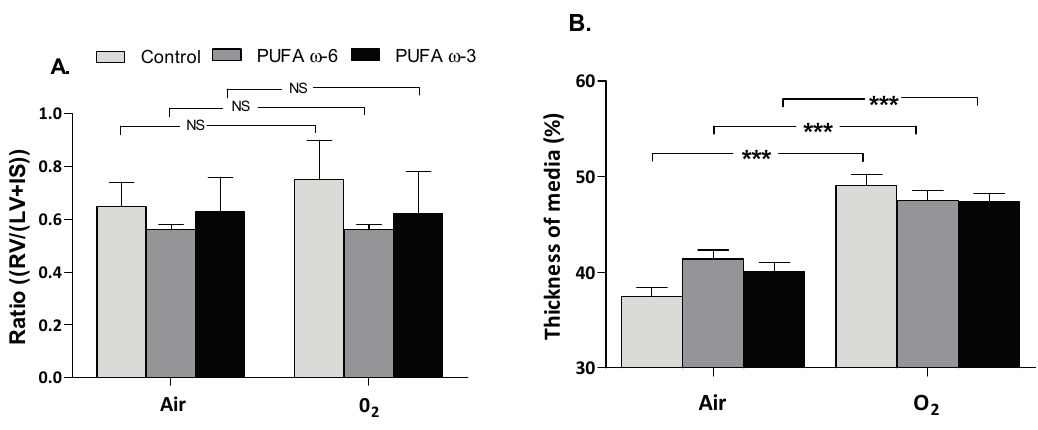
Figure 5. Heart and distal pulmonary arteries morphometry, comparing ratio (RV/(LV + IS)) in newborn rats exposed to hyperoxia or not ( A ) and the thickness of the media of distal pulmonary arteries ( B ) according to exposure and type of supplementation. Values are expressed as mean ± SEM ( n = 30 in PUFA ω -6/air, PUFA ω -3/air, PUFA ω -6/O 2 and PUFA ω -3/O 2 and n = 10 in control/air and control/O 2 ). RV: right ventricle; LV: left ventricle; IS: interventricular septum; *** p < 0.001; NS: not